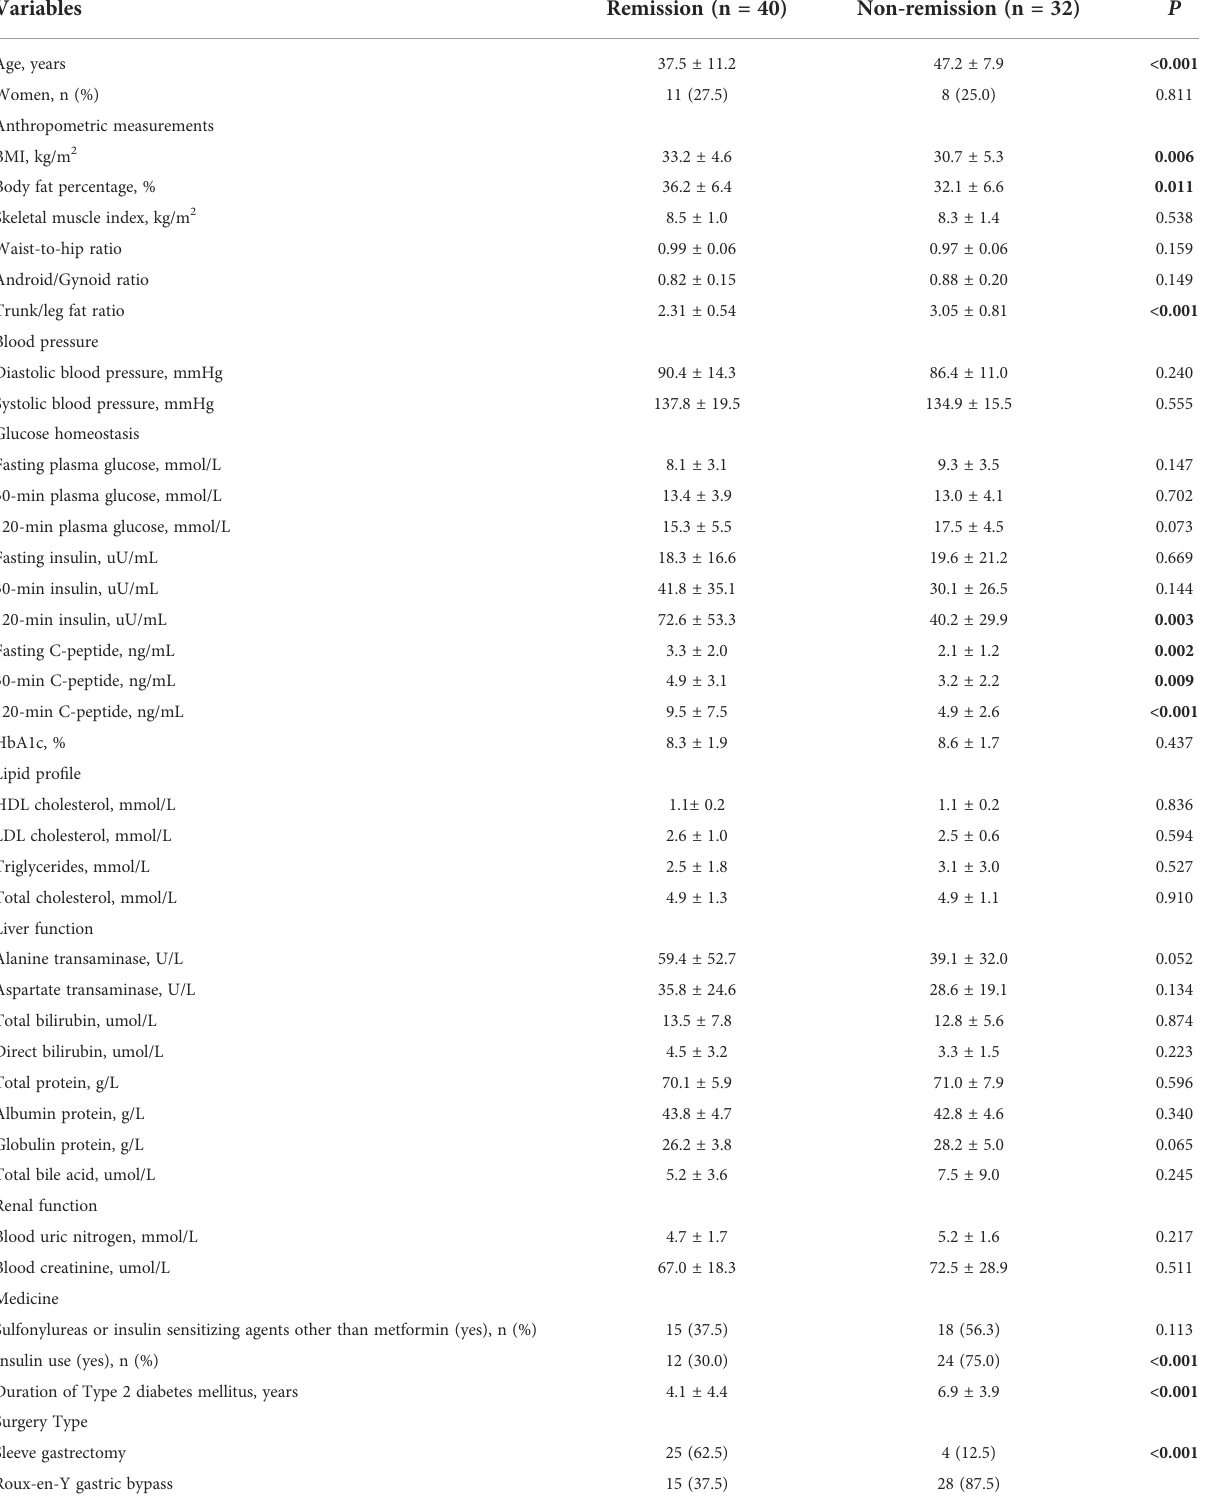
TABLE 1 Patient demographics and clinical characteristics at